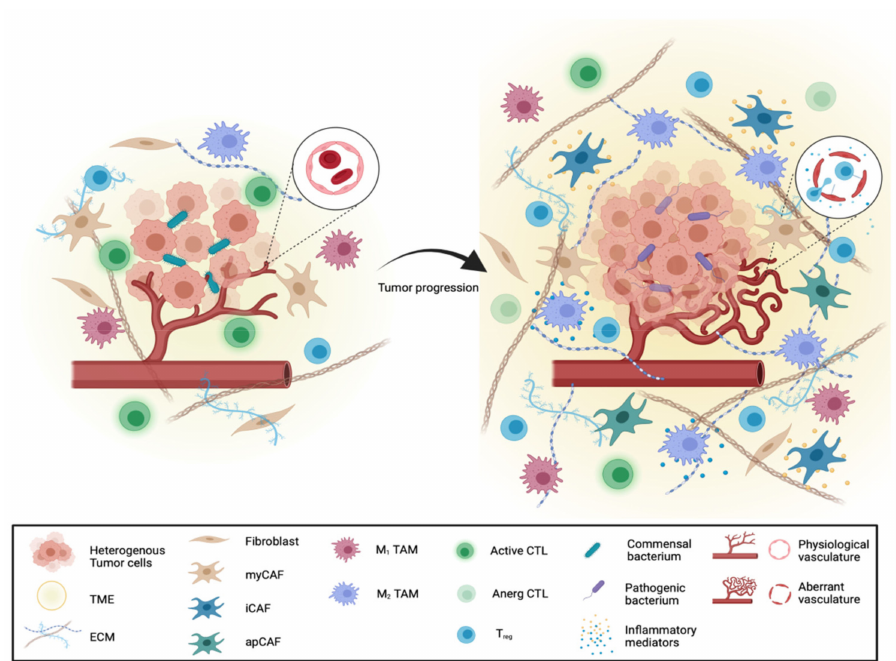
Figure 1. Pancreatic cancer is characterized by a high tumor and stroma heterogeneity. During pancreatic tumorigenesis, tumor cells acquire multiple alterations resulting in a heterogeneous pool of tumor cell clones. Along with the evolution of these divergent tumor cell clones, the tumor microenvironment (TME) also undergoes fundamental alterations involving, (i) activation of fibroblasts and transdifferentiation into carcinoma associated fibroblasts (CAFs) with different phenotypes (myCAF, iCAF, apCAF), (ii) alteration of the extent and composition of the extracellular matrix (ECM), (iii) enrichment of immunosuppressive and tumor-promoting immune cells e.g., tumor- associated macrophages with different phenotypes (M1 TAM versus M2 TAM), anergy cytotoxic T cells (CTL) and regulatory T cells (Treg), (iv) enrichment of pathological bacteria and extrusion of commensal bacteria, (v) elevation of inflammatory mediators and (vi) formation of new and modified blood vessels. Overall, this TME heterogeneity is an essential driver of PDAC development and progression. Figure created with